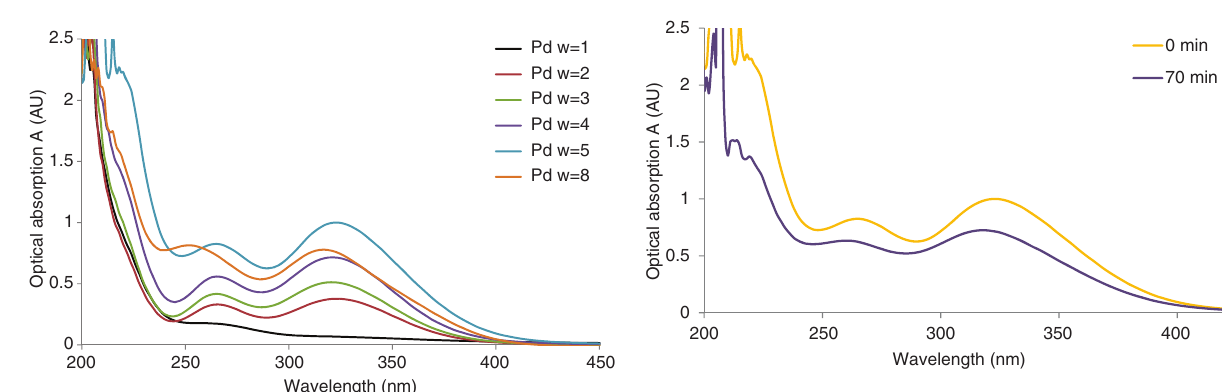
= 2.0 and ω = 5.0. 1 2